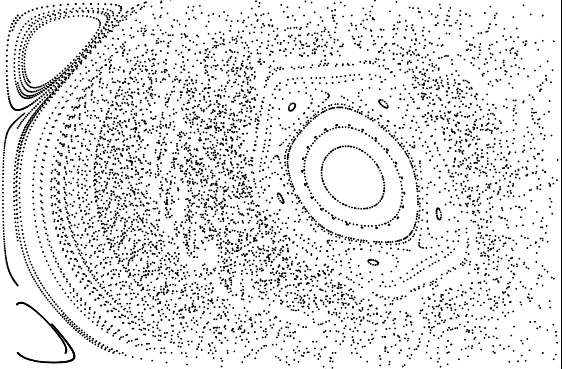
Figure 2. The Poincaré section is obtained from the periodic velocity in the half period of the channel with α = 1 and β = 1 / 3 . The Reynolds number is 0.1 in this flow.